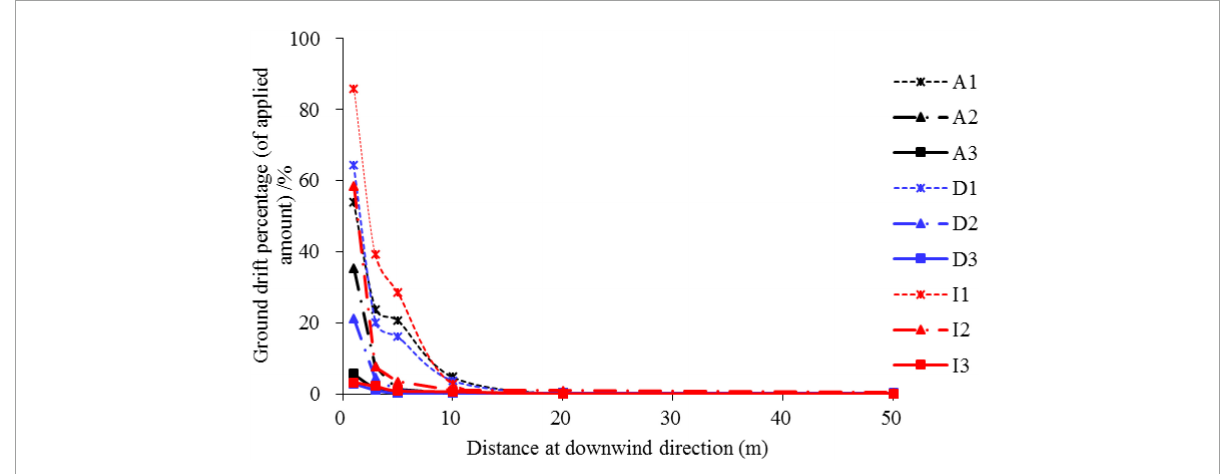
FIGURE10 The curve of downwind ground drift at the setting distance from the spray treated area. The letters A, D, and I represent Azoxystrobin, Difenoconazole, and Imidacloprid, respectively. The numbers 1, 2, and 3 represent the flight velocity at 1, 2, and 3 m/s, respectively.